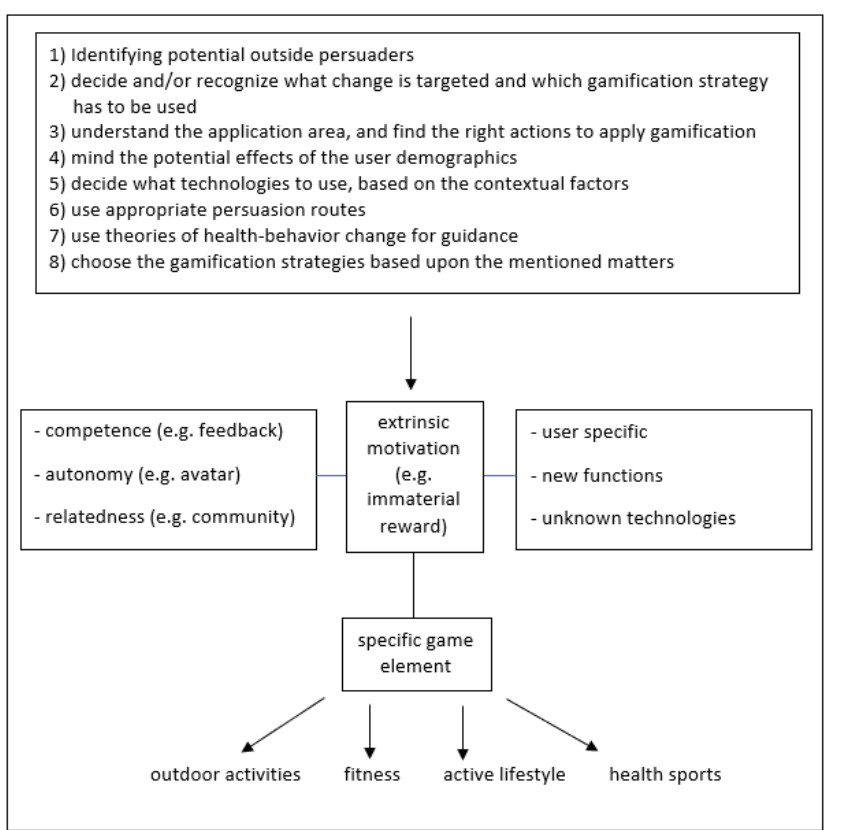
Figure 4. Design of an app to increase the physical activity (PA) of inactive persons.